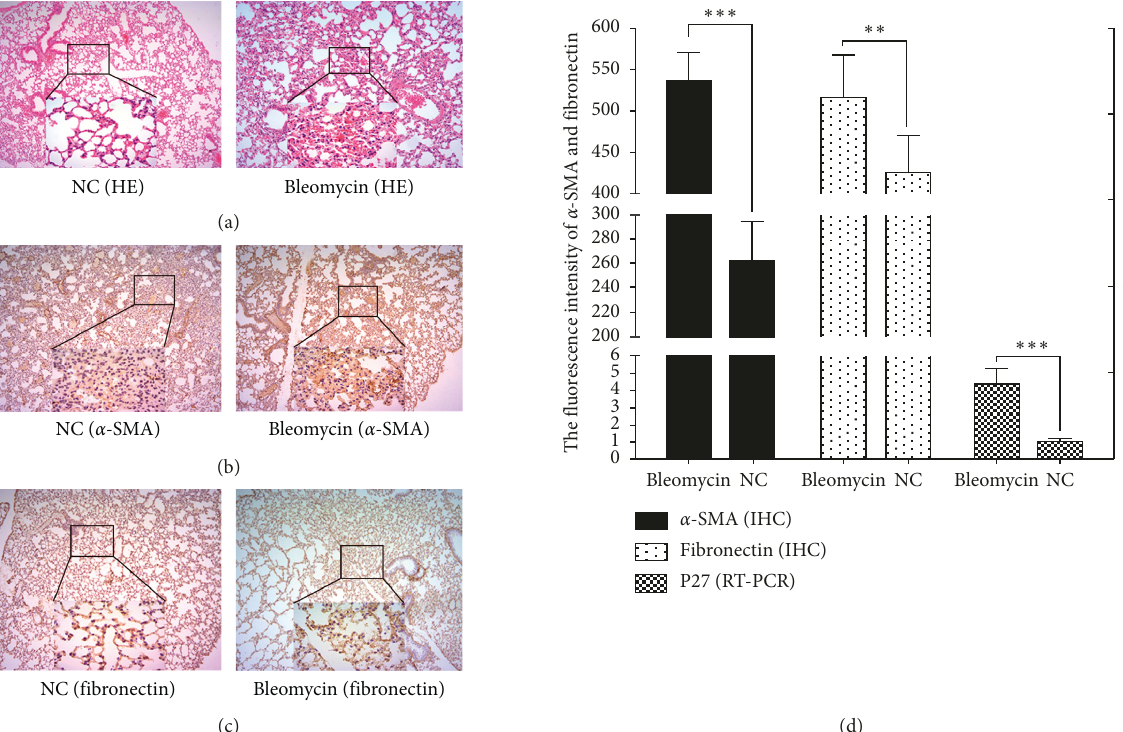
Figure 1: Expression of a-SAM, fibronectin, and P27 in bleomycin mouse lung fibrosis model. (a) H&E staining of lung fibrotic tissue in the NC and the bleomycin group. (b-c) Expression of a-SAM and fibronectin in the NC and the bleomycin group by IHC. (d) The relative expression of a-SAM, fibronectin, and P27 in the NC and the bleomycin group. The results of a-SAM and fibronectin expression were from the IHC staining density, and the results of P27 expression were from